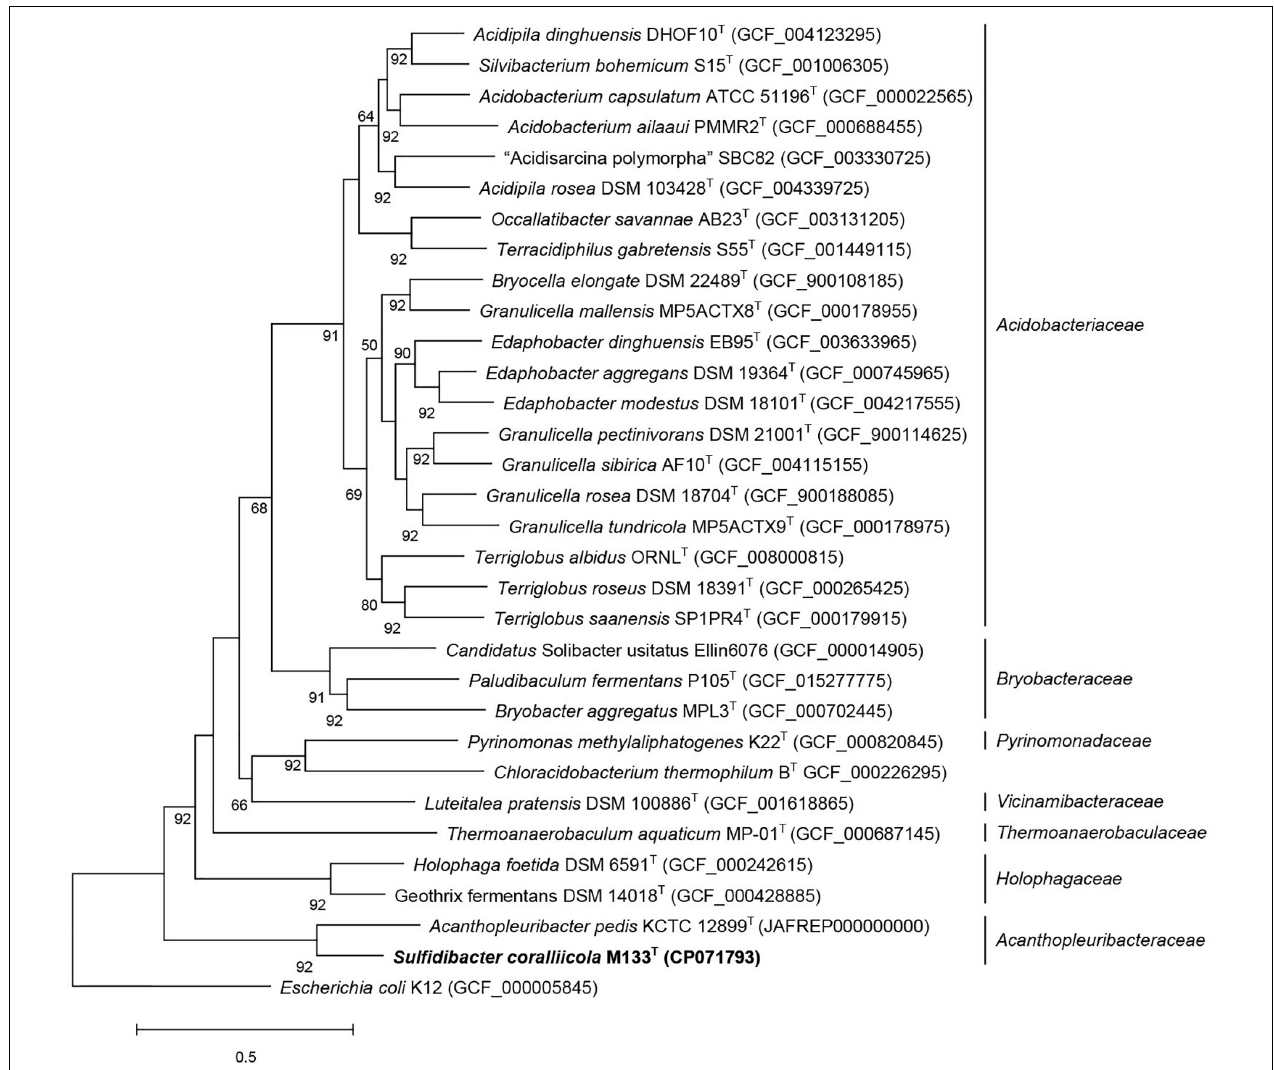
FIGURE 2 | Phylogenomic tree inferred using UBCGs (concatenated alignment of 92 core genes) indicated strain M133 T belongs to the family Acanthopleuribacteraceae . Gene support indices (GSIs) is given at branching points, only above 50% is displayed. Bar, 0.5 substitution per